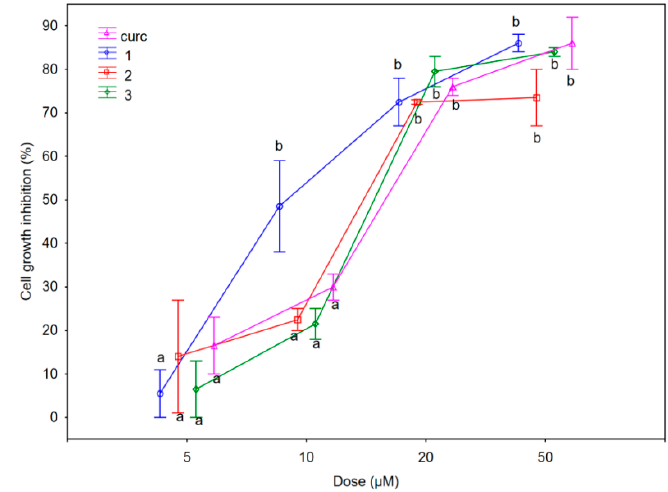
Figure 2. Cytotoxic activity of curcumin and its derivatives 1 – 3 on SUM 149 cells. Cell viability was assessed by MTS assay. Data are expressed as the mean of at least three di ff erent experiments performed in triplicate. Di ff erent letters represent significant di ff erences in cytotoxic activity among the concentration (Tukey test, p < 0.05).